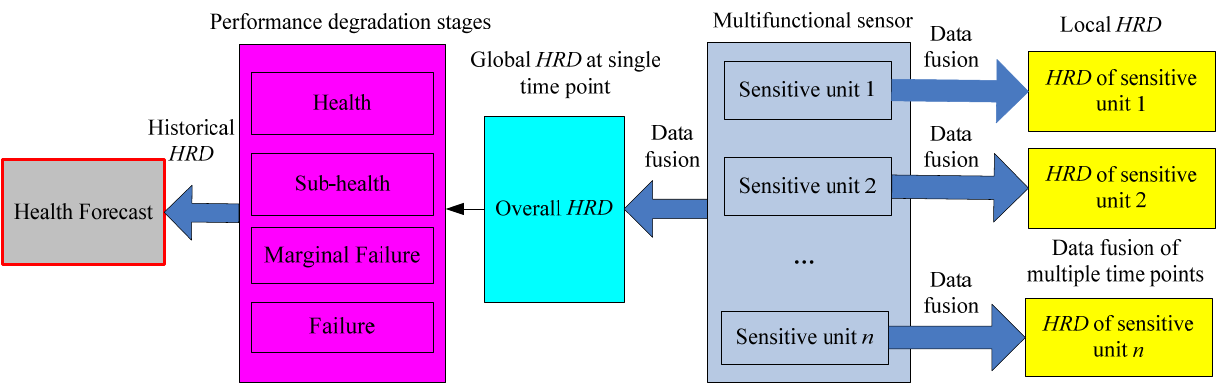
Figure 2. Health evaluation content of a multifunctional self-validating